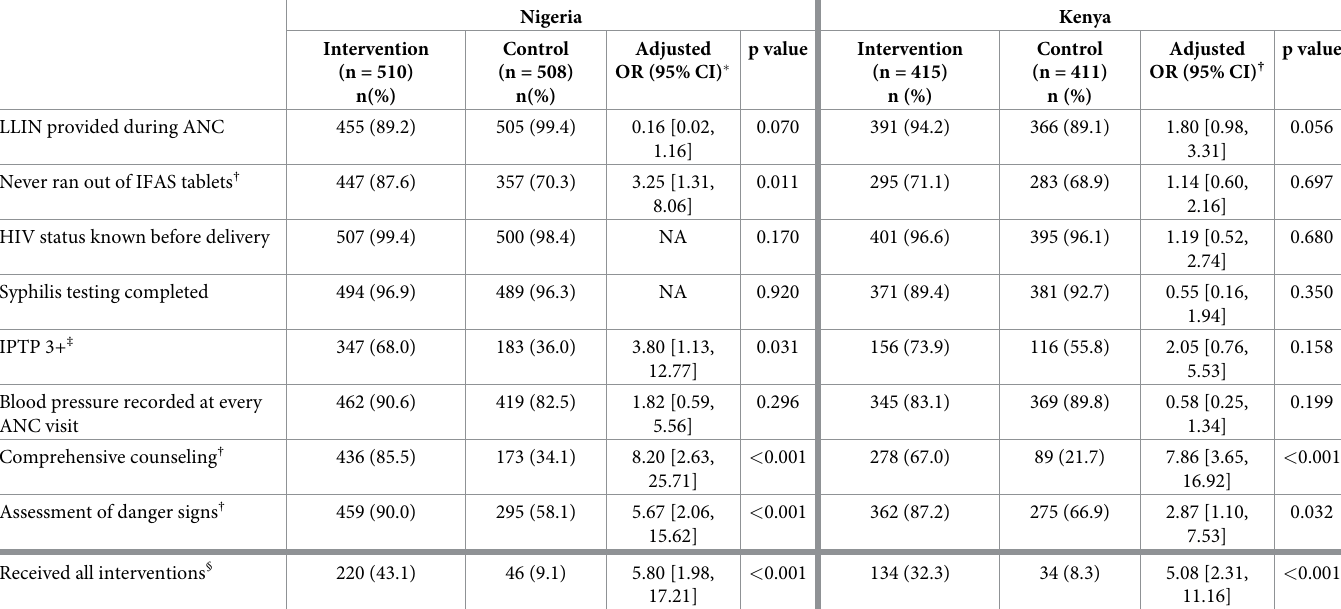
Table 3. Effects of G-ANC intervention on quality of